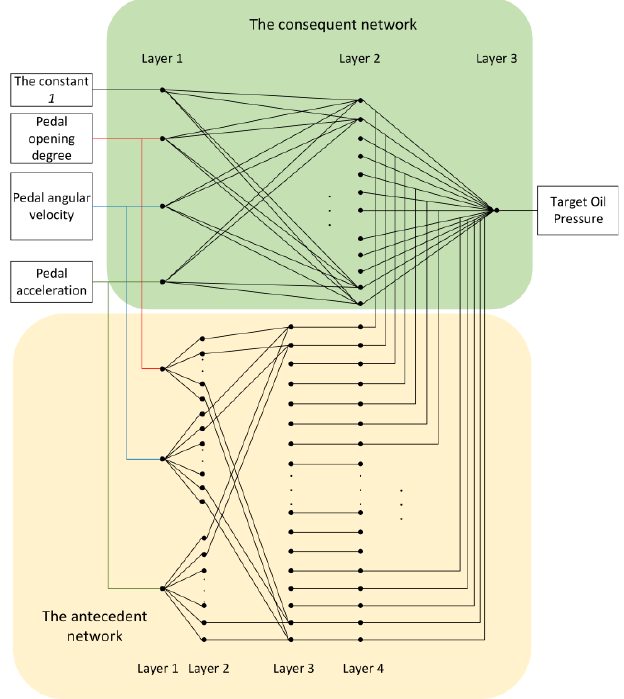
Figure 8. T-S fuzzy neural network model for target oil pressure recognition algorithm.